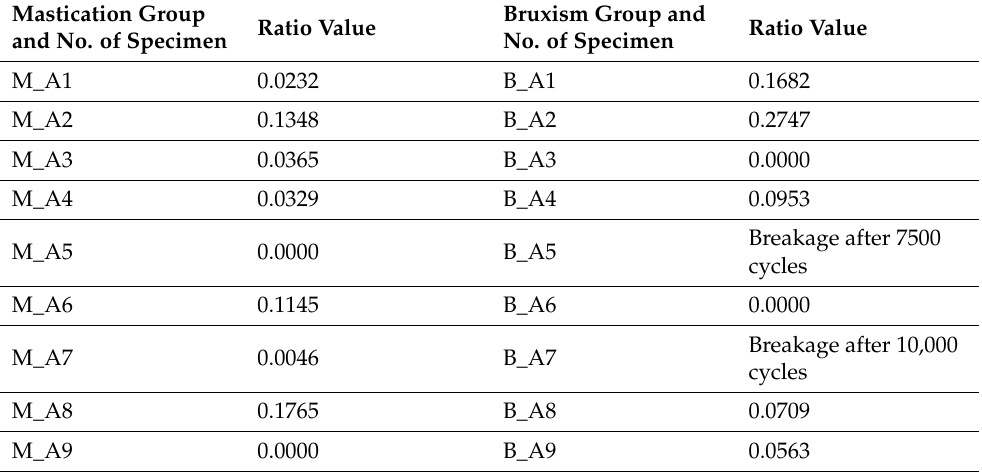
Table 1. Values of ratio between length of micro-infiltration and length of enamel-adhesive interface per 1 mm for each specimen, and material